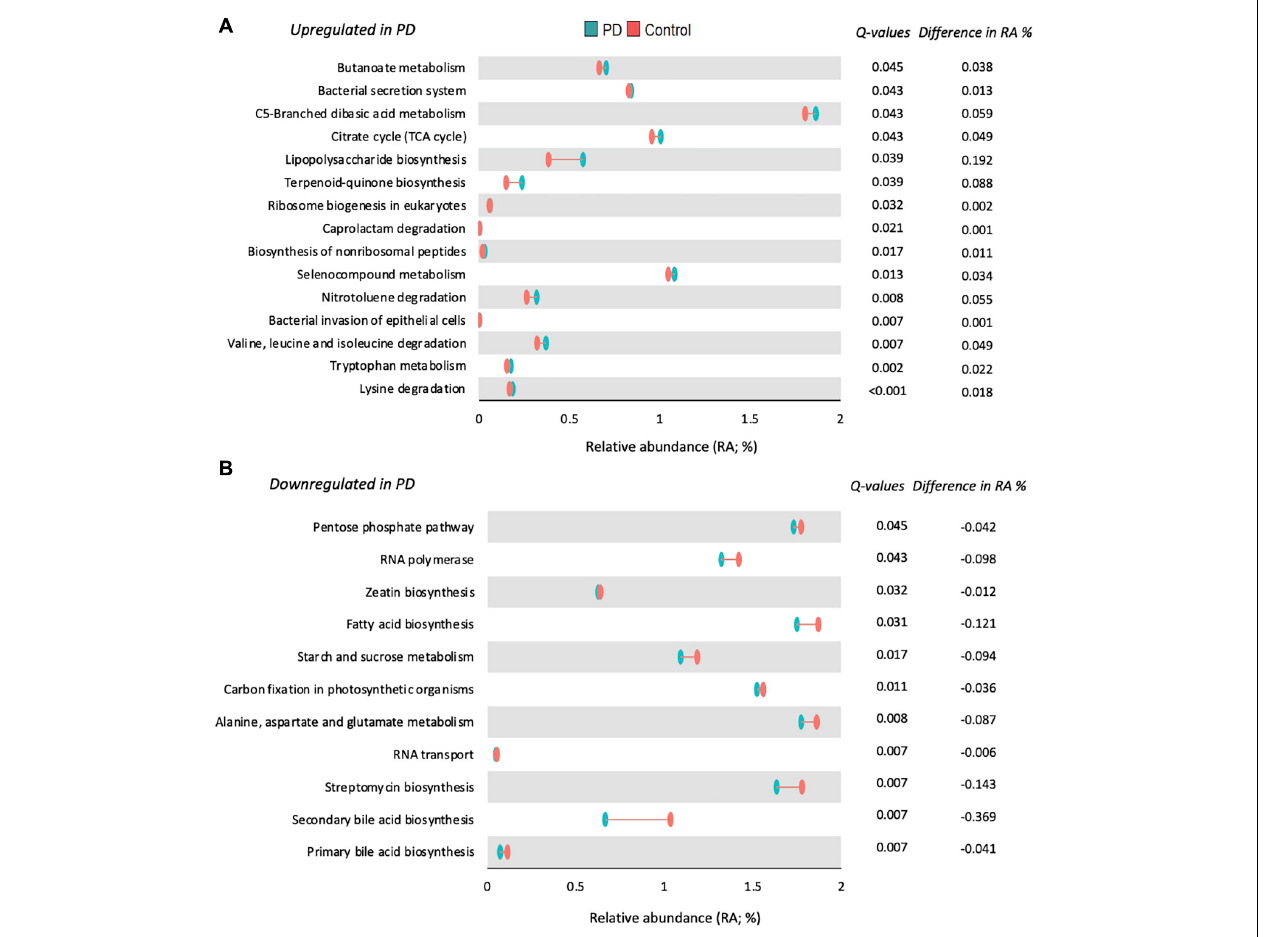
FIGURE 3 | Functional prediction of 26 significantly altered KEGG pathways in PwP. Differences in relative abundance of metabolite pathways predicted to be significantly upregulated (A) or downregulated (B) in PwP (blue) compared to controls (red). Q -values are presented to the right of each pathway and were generated using Wilcoxon rank-sum test followed by FDR adjustment with Storey’s q -value. The difference in median relative abundance between PwP and control participants is also presented. q < 0.05 was considered statistically significant. Figures were created using R v.